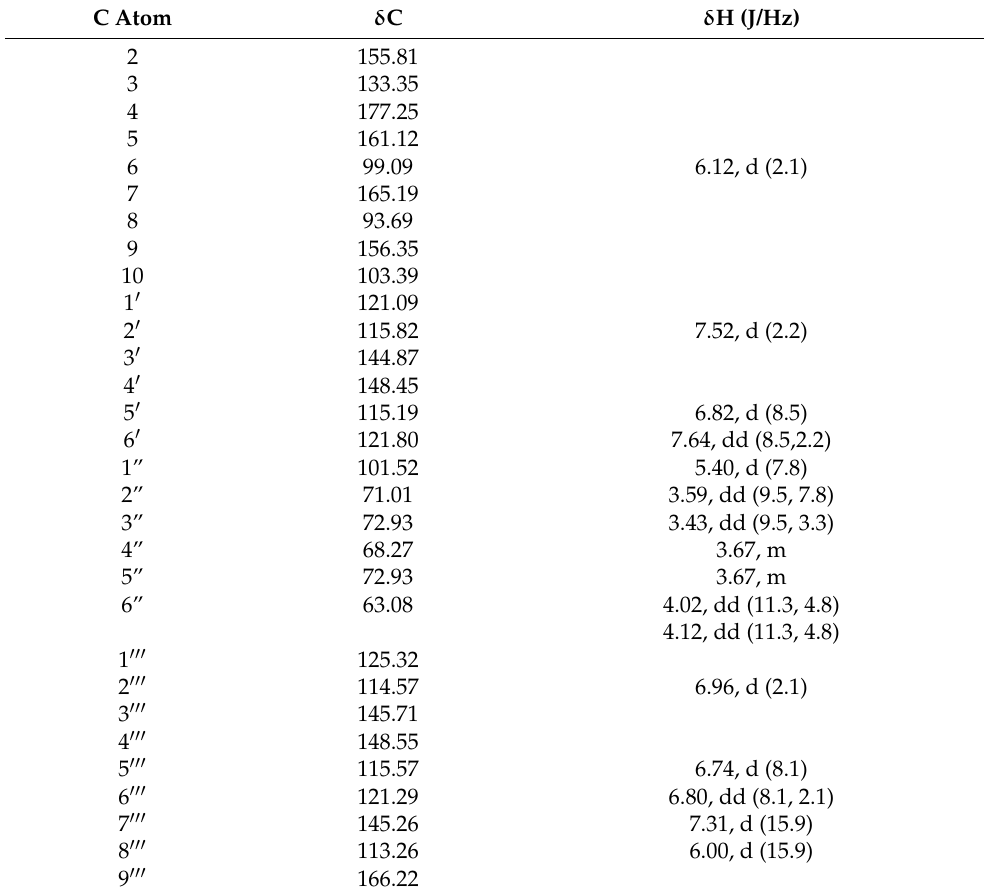
Table A1. 1 H and 13 C NMR of CC7, (DMSO-d6 (39.52 ppm), δ , ppm, J/Hz, 600